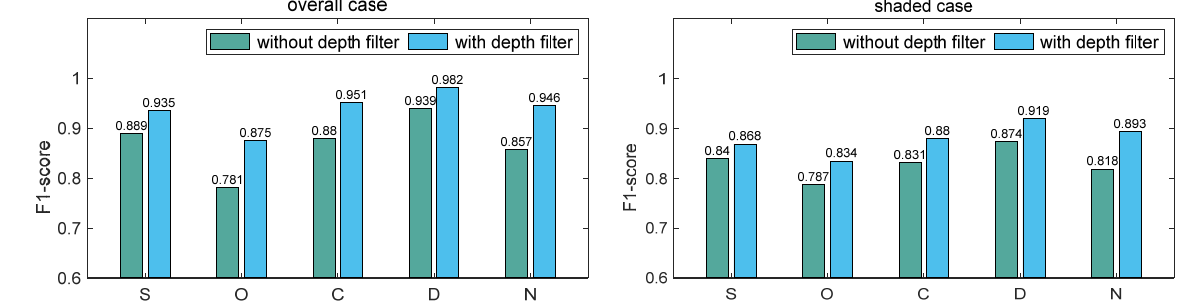
Figure 11. The results of ablation experiment for overall and shaded cases.